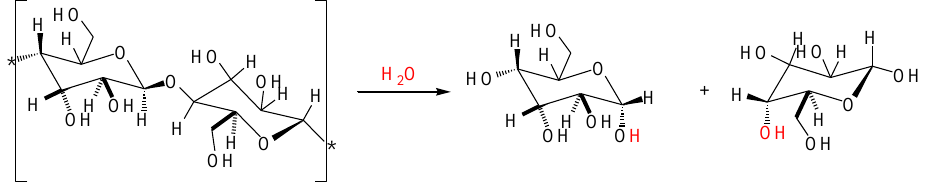
Figure 1. Hydrolysis reaction of cellulose structure.